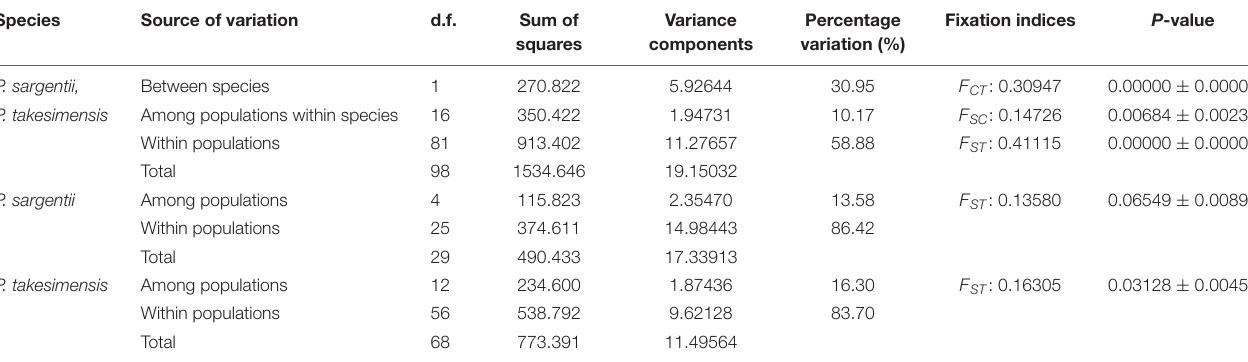
Variance Percentage Fixation indices P squares components variation (%)